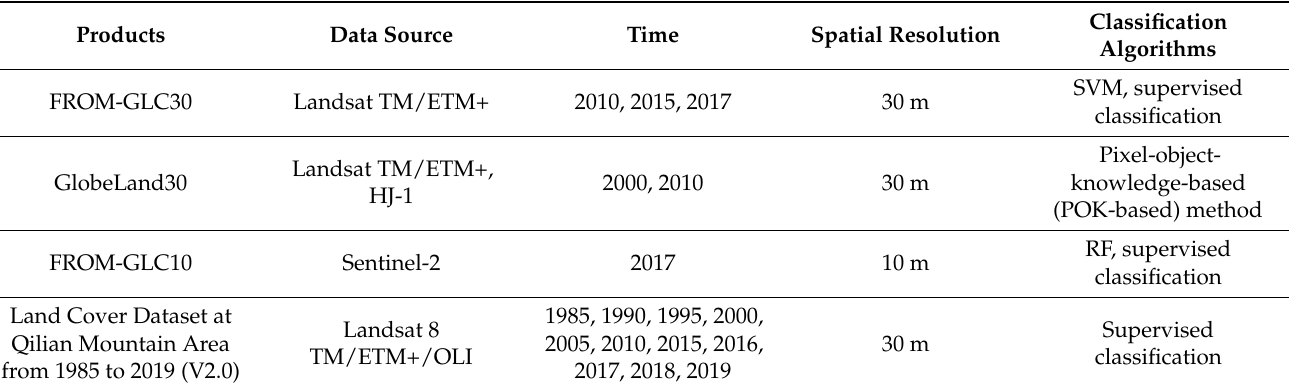
Table 1. Basic information of existing land cover